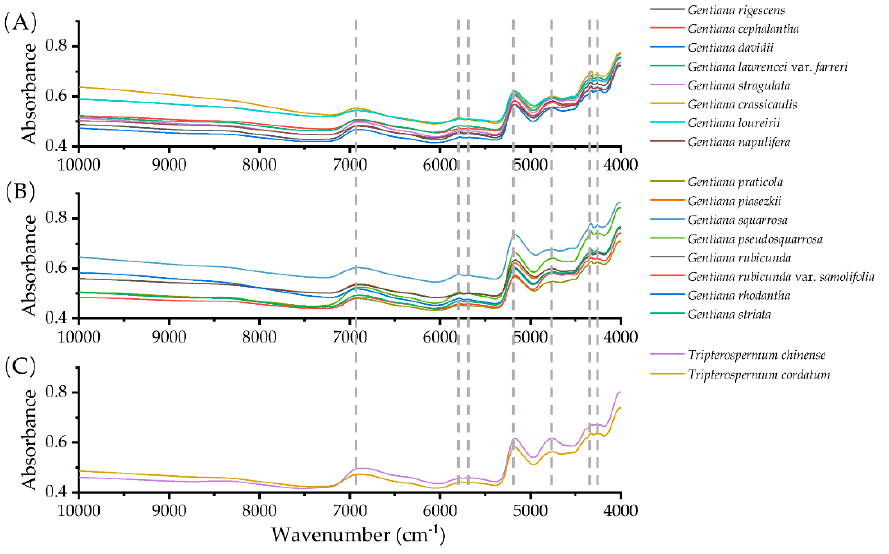
Figure 2. Averaged NIR spectra of 18 species of Gentiana ( A ), ( B ) and Tripterospermum species ( C ).